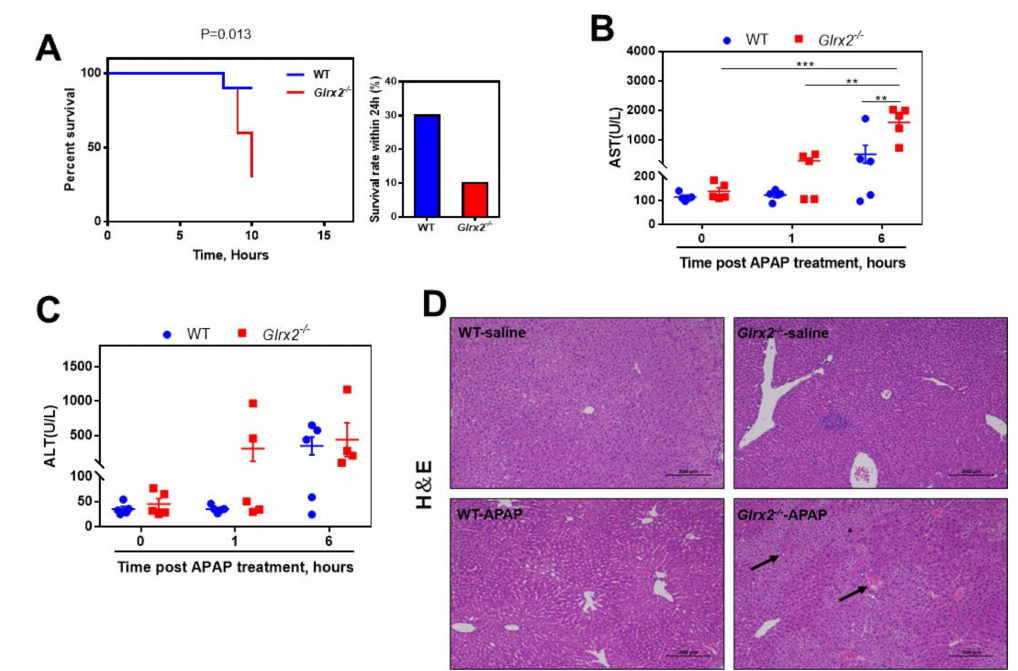
Figure 1. Glrx2 knockout increased liver sensitivity to acetaminophen (APAP) challenge. ( A ) Survival curve and survival rate of mice exposed to APAP challenge. Both WT and Glrx2 − / − mice were treated with 600 mg · kg − 1 APAP, and the survival of mice were monitored to obtain the survival curve within 10 h and survival rate within 24 h, n = 10. ( B , C ) The activities of aspartate aminotransferase (AST) and alanine aminotransferase (ALT) in serum in mice after treatment with 300 mg · kg − 1 APAP. The statistical difference was analyzed by two-way ANOVA. Data are shown as mean ± SEM, n = 5, ** p < 0.01; *** p < 0.001. ( D ) Pathological morphology of liver from mice treated with 300 mg · kg − 1 APAP at 6 h after administration, assessed by hematoxylin-eosin (HE) staining. Arrows point to necrotic